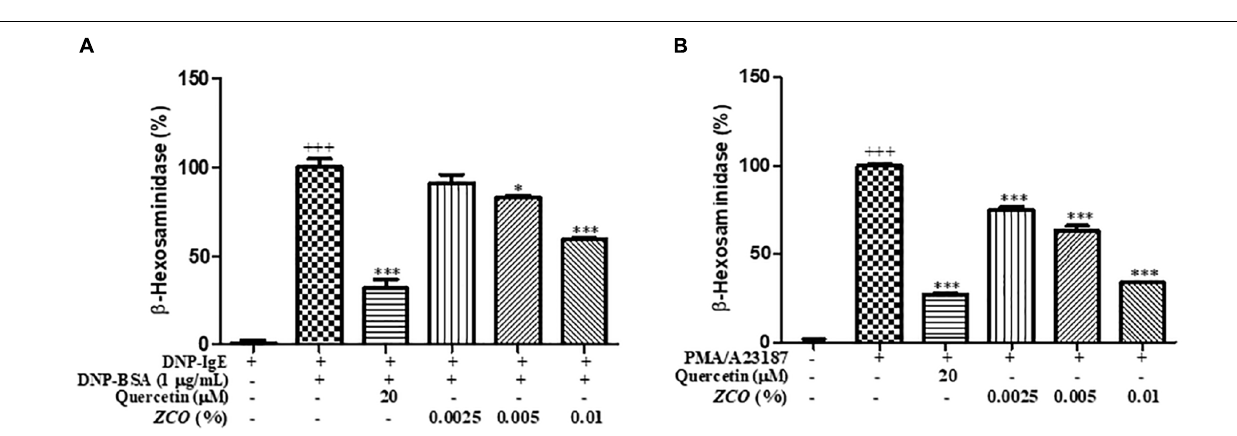
FIGURE 2 | Effect of ZCO on β -hexosaminidase secretion in RBL-2H3 cells. (A) RBL-2H3 cells incubated into 48-well plate (2 × 10 5 cells/mL) in MEM with 10% FBS and IgE anti-DNP a 37 ◦ C overnight were washed with SB buffer, and then were pretreated with ZCO (0.0025, 0.005, and 0.01%) or quercetin (20 µ M) with SBC buffer for 1 h prior to stimulation with DNP-BSA (1 µ g/mL) for 30 min. The supernatants were collected for β -hexosaminidase assay. Experiments were conducted in quadruplicate and expressed as mean ± SEM ( ∗ P < 0.05; ∗∗∗ P < 0.001 versus with DNP-BSA group). (B) RBL-2H3 cells incubated into 48-well plate overnight were washed with SB buffer, and then pretreated with ZCO or quercetin with SBC buffer for 1 h prior to stimulation with 30 ng/mL of PMA plus 350 ng/mL of A23187 for 1 h. The supernatants were collected for the detection of β -hexosaminidase ( ∗∗∗ P < 0.001 versus with PMA/A23187 group). +++ means the significance compared with the mock cells (deal with